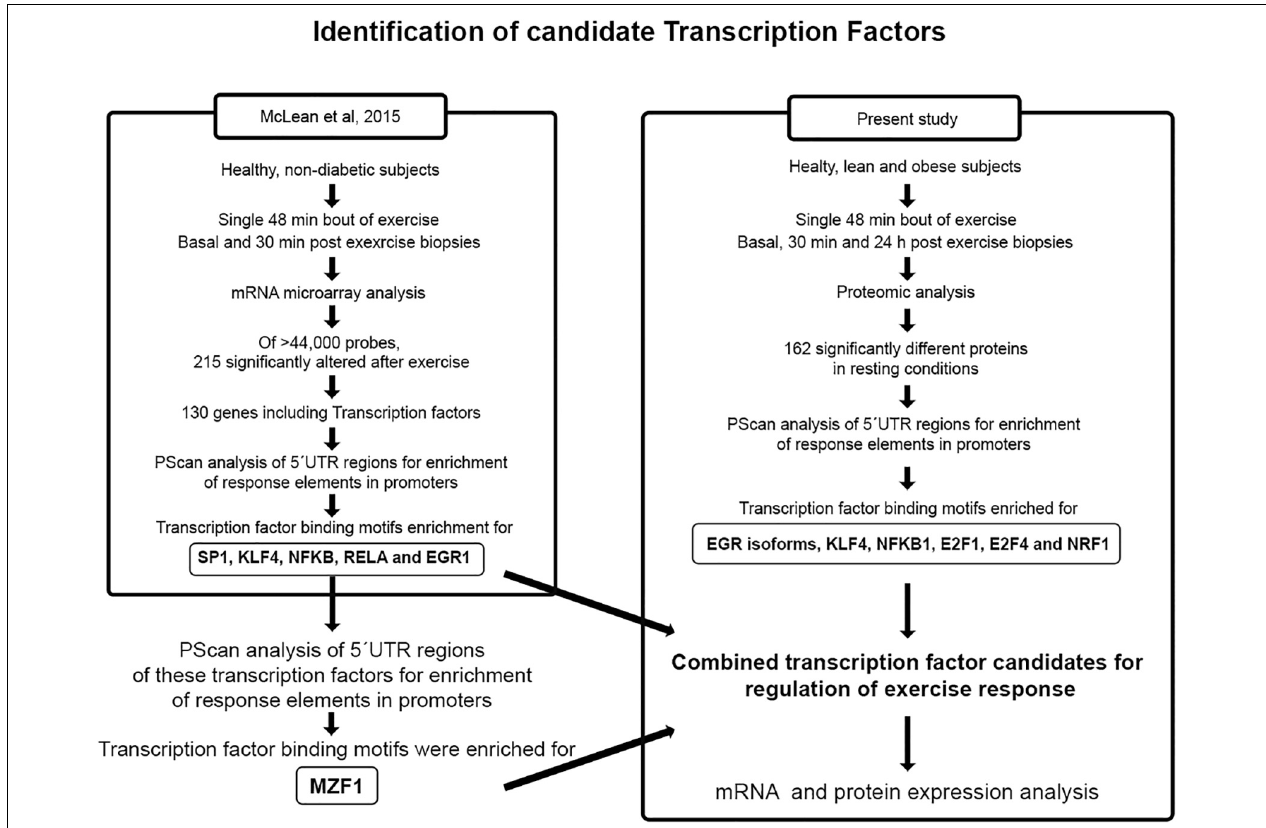
FIGURE 2 | Identification of candidate transcription factors. The identification of transcription factors that are likely to regulate the molecular response to exercise was performed by PScan analysis of 5 (cid:48) UTR regions for enrichment of response elements in the promoters of genes alter by exercise (McLean et al., 2015) and proteins differentially expressed in resting conditions in lean and obese healthy